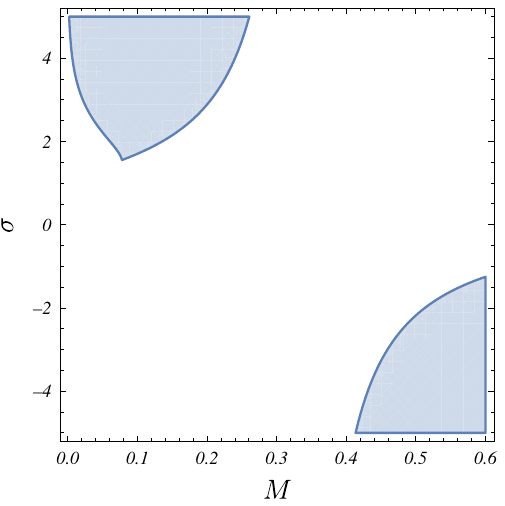
Fig. 1 Theregionsofpositivedefiniteinformationmetrictogetherwith C > 0 (the shaded regions) for the DST black hole with respect to the Quevedo information approach. The upper region lies within 1 < σ < ∞ and 0 < M < 1 / 3, while the lower region is defined within −∞ < σ < − 1 / 2 and 1 / 3 < M < ∞